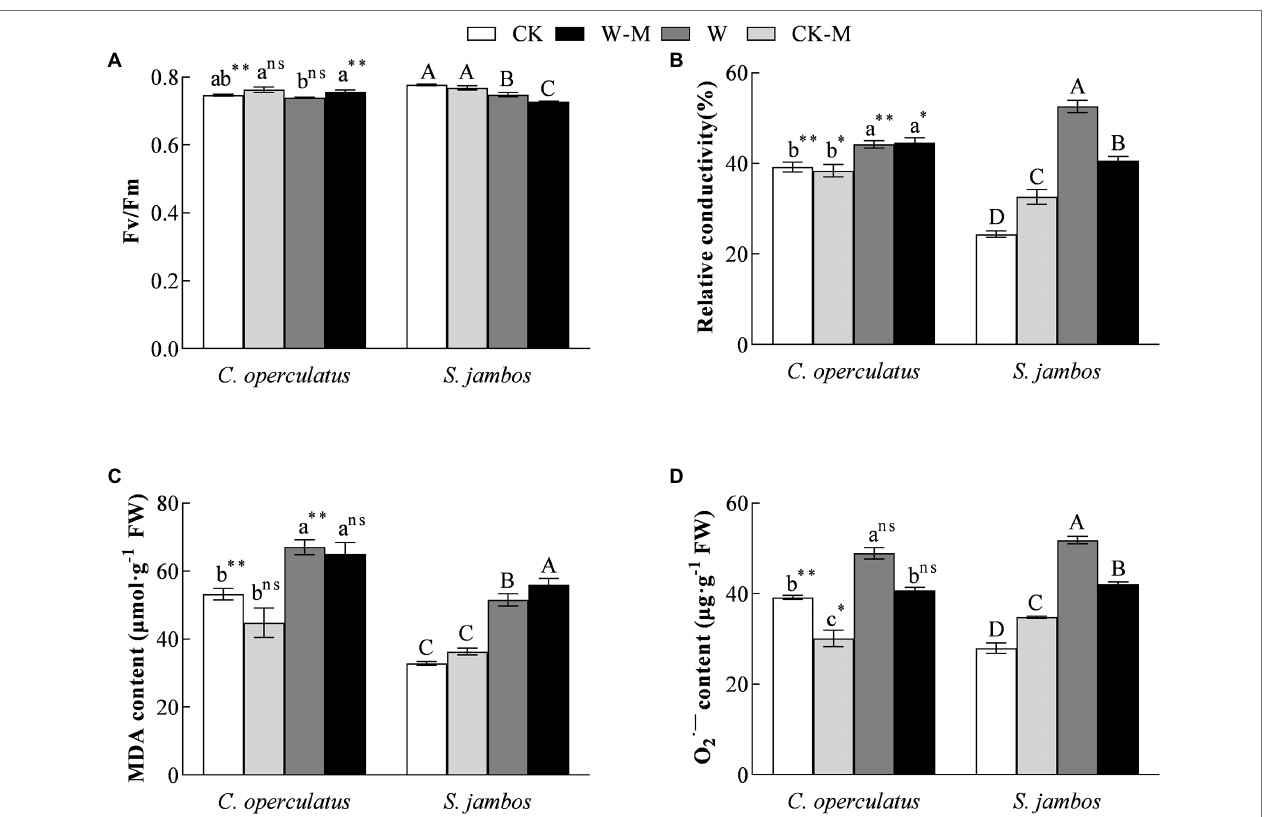
FIGURE 3 | The variations of Fv/Fm (maximum photochemical quantum yield of PSII) (A) , relative conductivity (B) , MDA content (C) and O 2 ×- content (D) in C. operculatus and S. jambos among different treatments. Values are means ± SE ( n = 6). Different little and capital letters indicate significant differences among different treatments within the same species according to ANOVA’s test ( p < 0.05). CK, pure planting pattern under well-watered condition; CK-M, mixed planting pattern under well-watered condition; W, pure planting pattern under waterlogging condition, W-M; mixed planting pattern under waterlogging condition. The signs such as *, **, and ns concern the significance difference between the two species under the same treatment. * p < 0.05; ** p < 0.01; ns,